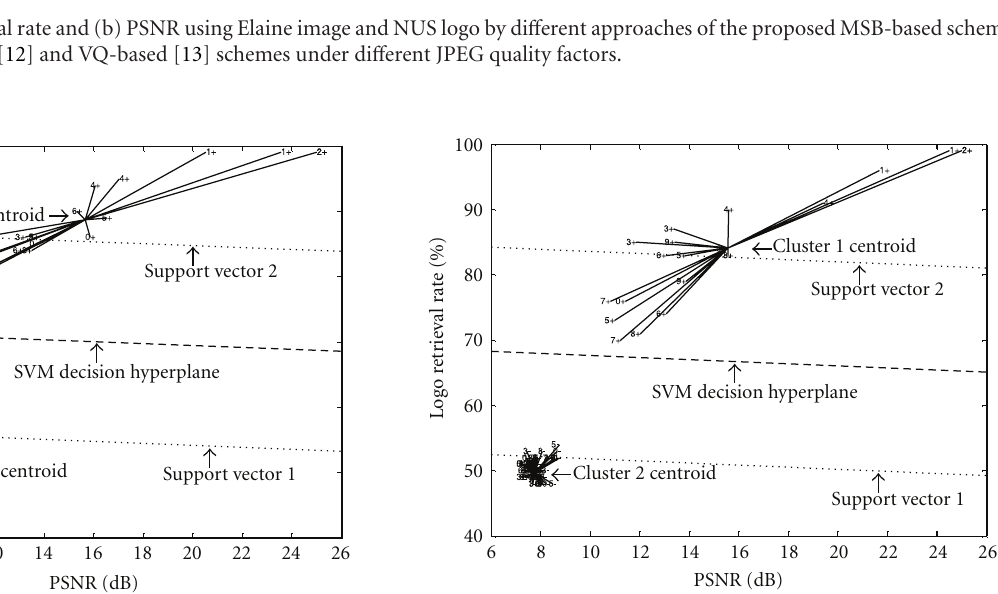
Figure 6: SVM classification and K -means clustering results by the UROI approach of the proposed MSB-based scheme. Note that the distance between support vectors by SVM [27] is d = 30 . 2 and cluster 1 and cluster 2 are positive and negative clusters, respectively, by K -means clustering algorithm [28]. Attack numbers 0–9 are referred using Table 3.